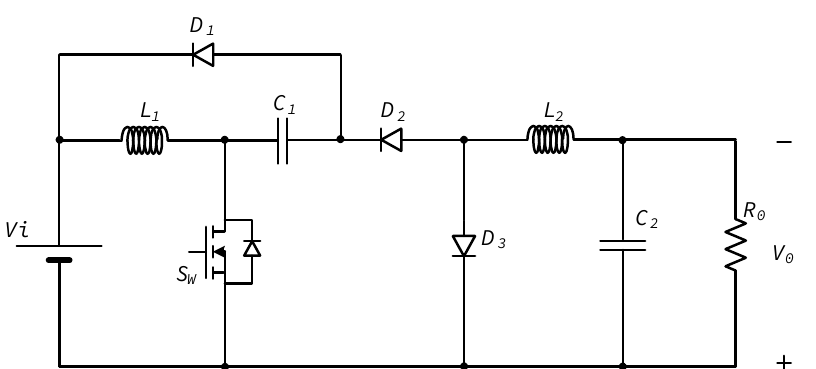
Figure 2. Extended-buck DC-DC converter with extended duty cycle in the output voltage buck region. PV panels must track the maximum power point (MPP) with very small deviations (ripple) around this MPP. To minimize the switching ripple, for a given set of inductors